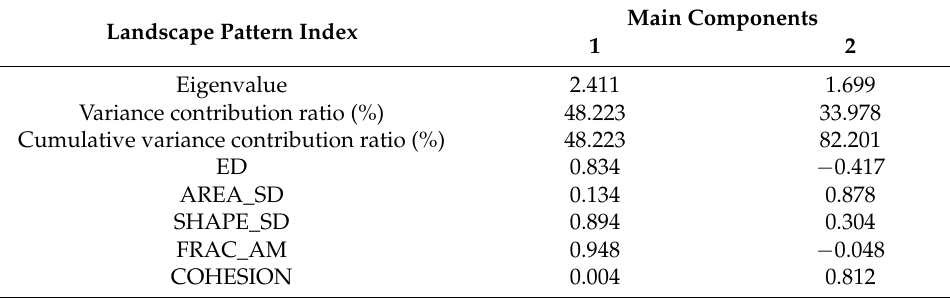
Table 5. Results of the Landscape Pattern Index Factor